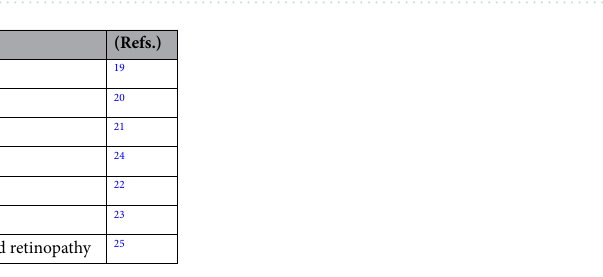
Figure 2. Correlations between the mean VMHC values and the clinical behaviors. ( a ) The HADS scores showed a negative correlation with the VMHC values of the frontal sup (r = − 0.834, p < 0.001), and ( b ) the HADS scores showed a negative correlation with the VMHC values of the temporal inf (r = − 0.797, p < 0.001). VMHC voxel-mirrored homotopic connectivity, HADS hospital anxiety and depression scale.